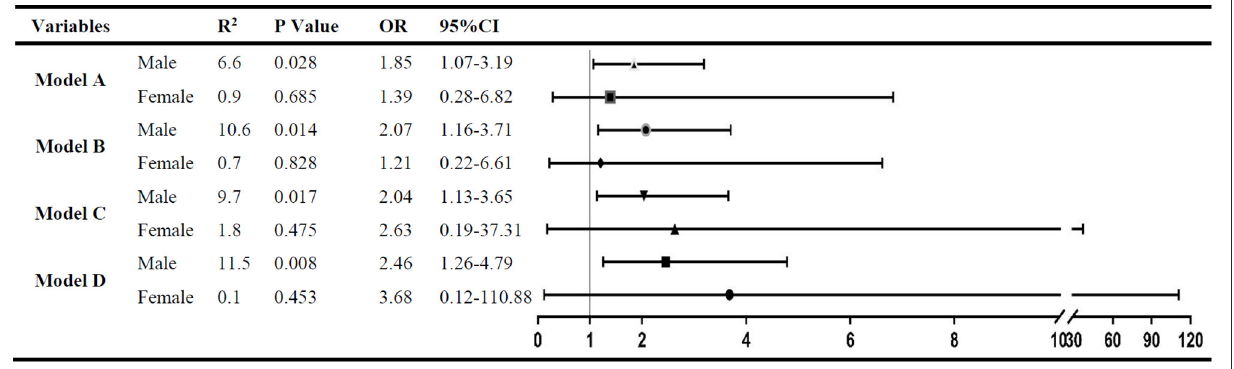
FIGURE2 The multivariate analysis to identify the association between RUI and spontaneous HT. Variables adjusted in logistic regression models: Model A. Factors with a P < 0.05 in male (or female) subgroup univariate analysis were included; model B: factors with a P < 0.05 in both subgroup univariate analysis were included; model C: variables in model B plus antiplatelet treatment and anticoagulant treatment; and model D: variables in model C plus smoking, alcohol consumption, systolic blood pressure, and